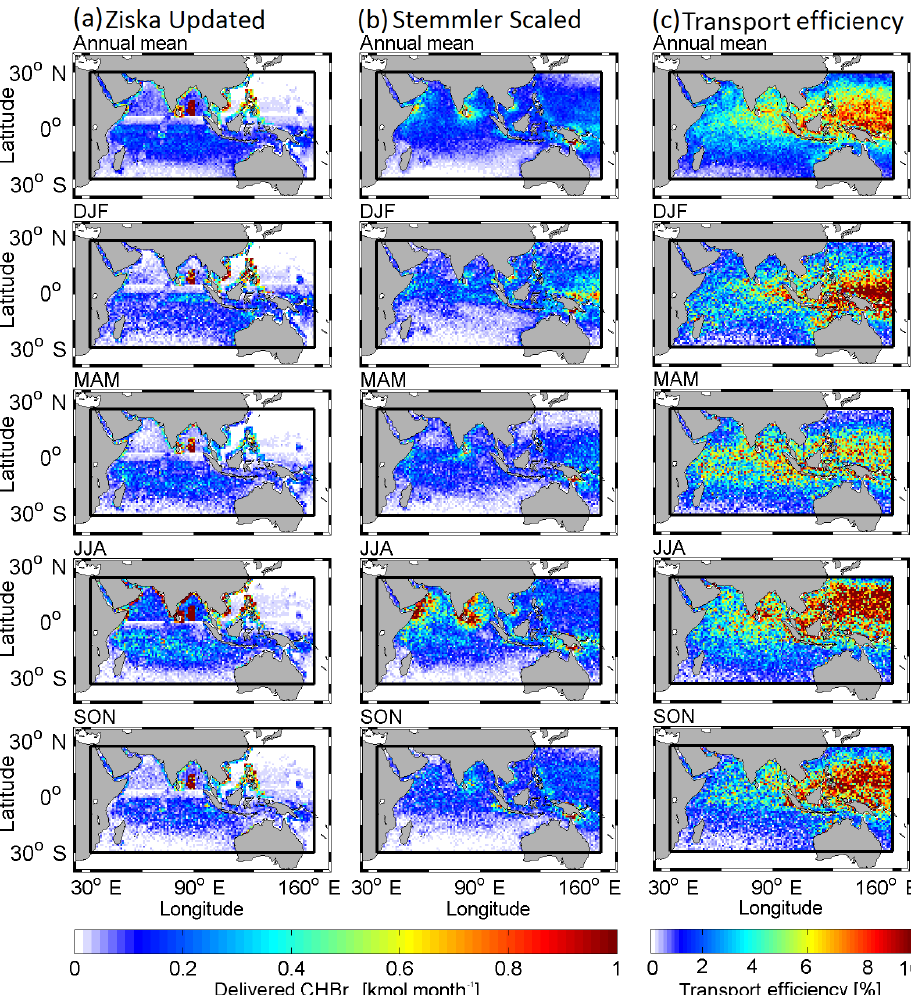
Figure 4. (a) Oceanic source regions of bromoform delivered to the cold point tropopause (CPT) for the Ziska Updated inventory with monthly averaged emissions. (b) Like (a) but for Stemmler Scaled. (c) Source region transport efficiency for bromoform delivery to the CPT from (a) and (b) . The black box depicts the Indian Ocean and west Pacific release